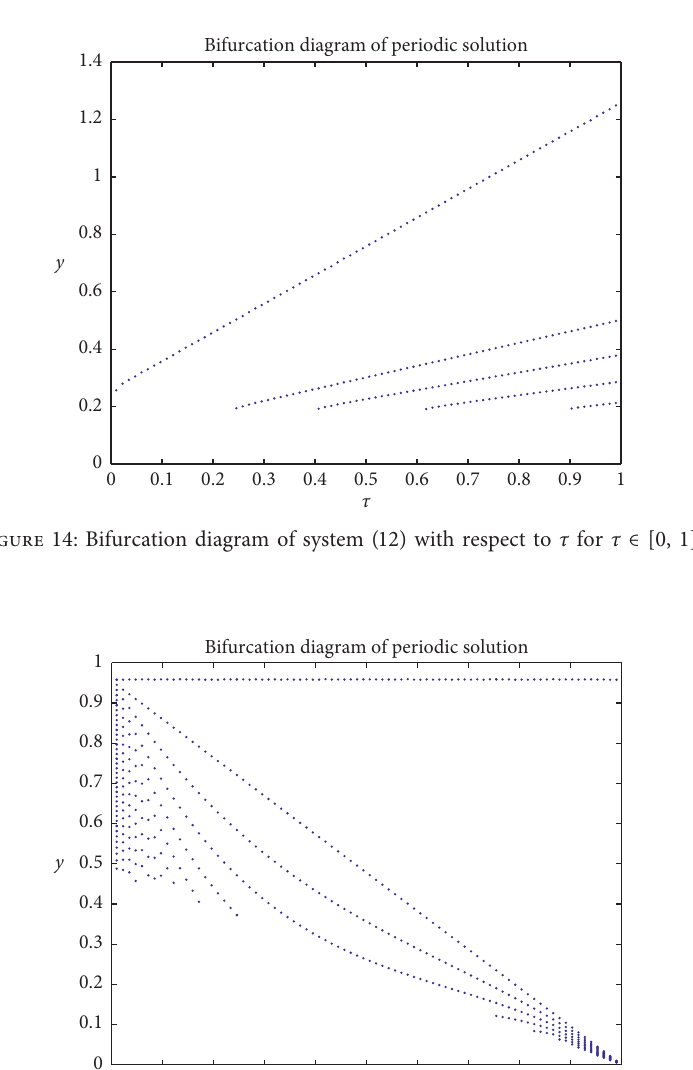
Figure 13: Orbital stability of the order-2 periodic solution of system (12). Control parameters: p � 0.6 and τ � 0.4.